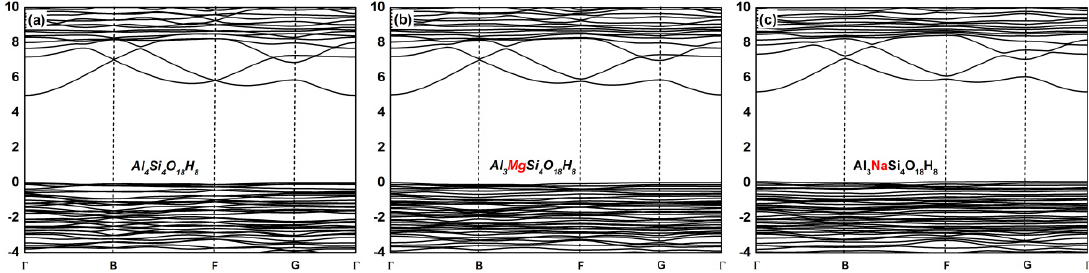
Figure 2. The band structure of the undoped kaolinite and doped kaolinite along high-symmetry lines in the Brillouin zone. ( a ) The band structure of the undoped kaolinite (Al 4 Si 4 O 18 H 8 ), ( b ) the band structure of Mg-doped kaolinite (Al 3 MgSi 4 O 18 H 8 ), and ( c ) the band structure of Na-doped kaolinite (Al 3 NaSi 4 O 18 H 8 )